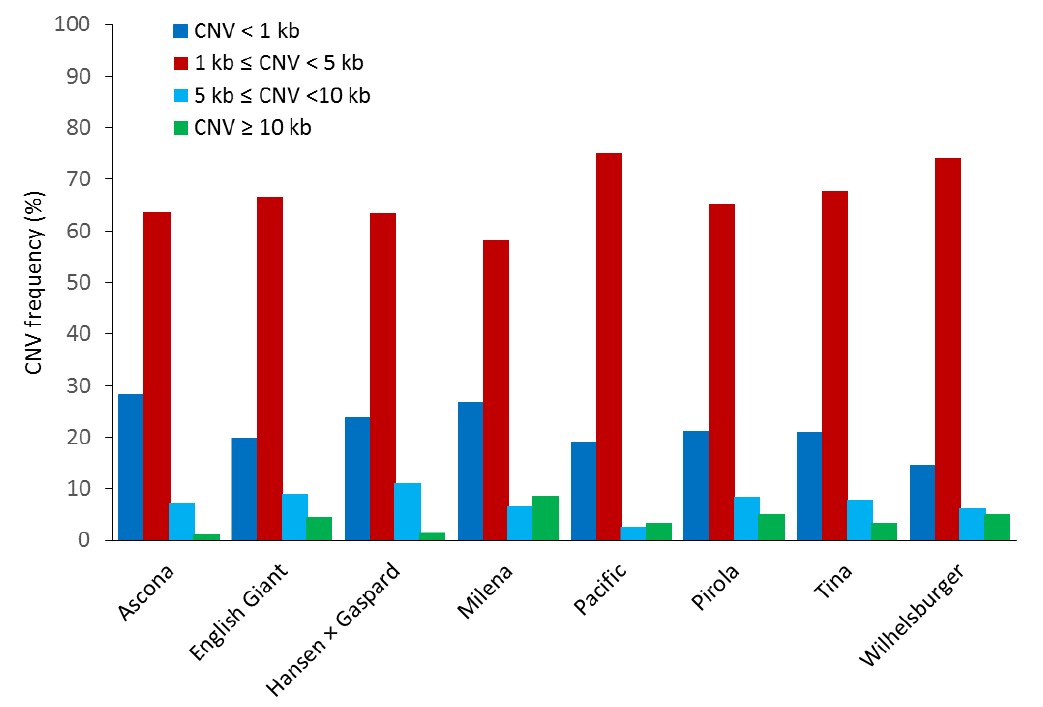
Figure 5. Size range distribution of CNVs in eight winter type and blackleg resistant B. napus lines. Each colour (bin) represents a different range of CNV lengths and the bars show the percentage of CNVs falling into each size bin.